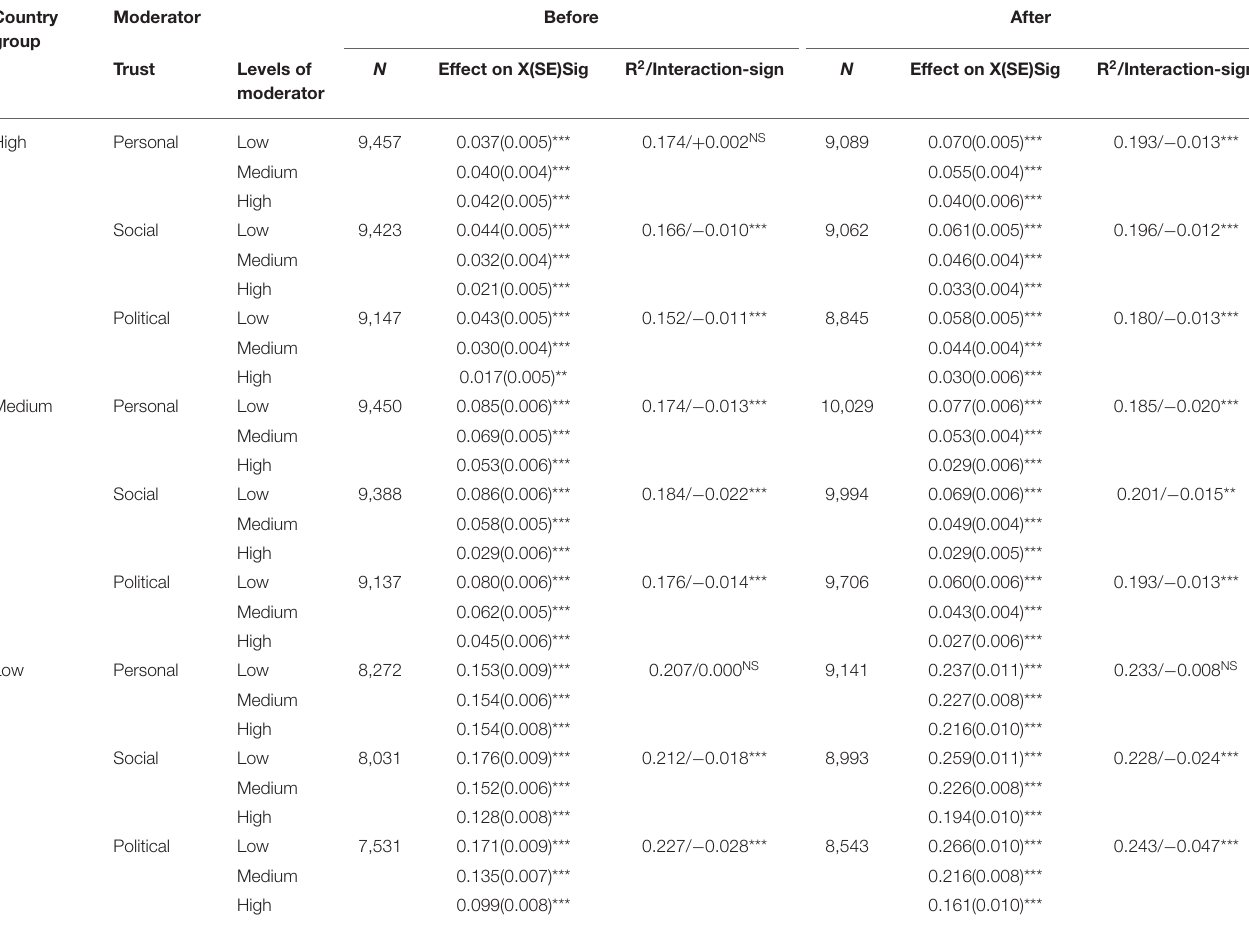
TABLE 5 | Results of the analysis for the moderator role of personal, social, and political trust for X = personal income and Y = LS, separated by before and after the financial crisis of 2008/2009 and country group as defined by overall trust. Country